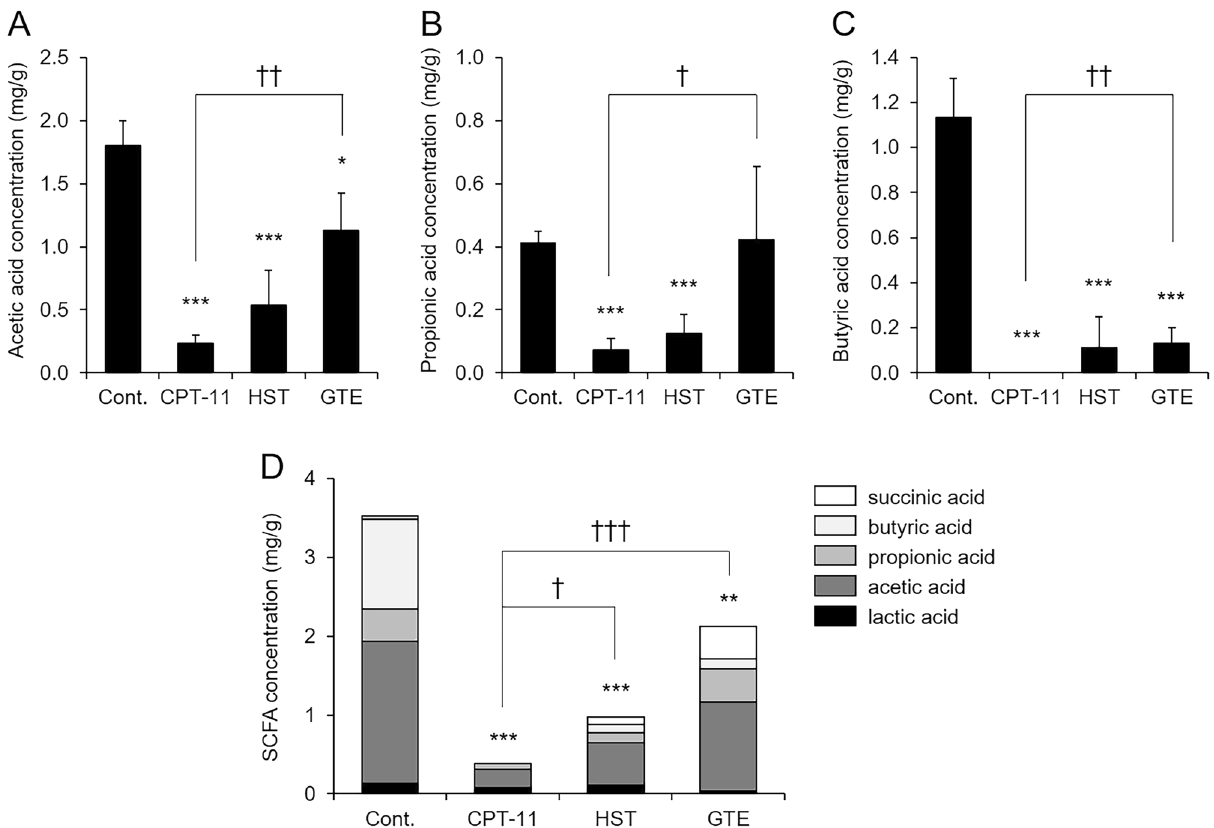
Figure 5. Changes in SCFA concentrations in the cecum after CPT-11 and GTE treatment. Rats were administered CPT-11 or lactic acid buffer intravenously for 4 days, and HST or GTE was administered in combination. Acetic acid ( A ), propionic acid ( B ), butyric acid ( C ), and total SCFA concentrations ( D ) in the cecum were measured by HPLC (mean ± S.D., n = 5, * p < 0.05, ** p < 0.01, *** p < 0.001 vs. Cont., † p < 0.05, †† p < 0.01, ††† p < 0.001 vs. CPT-11).